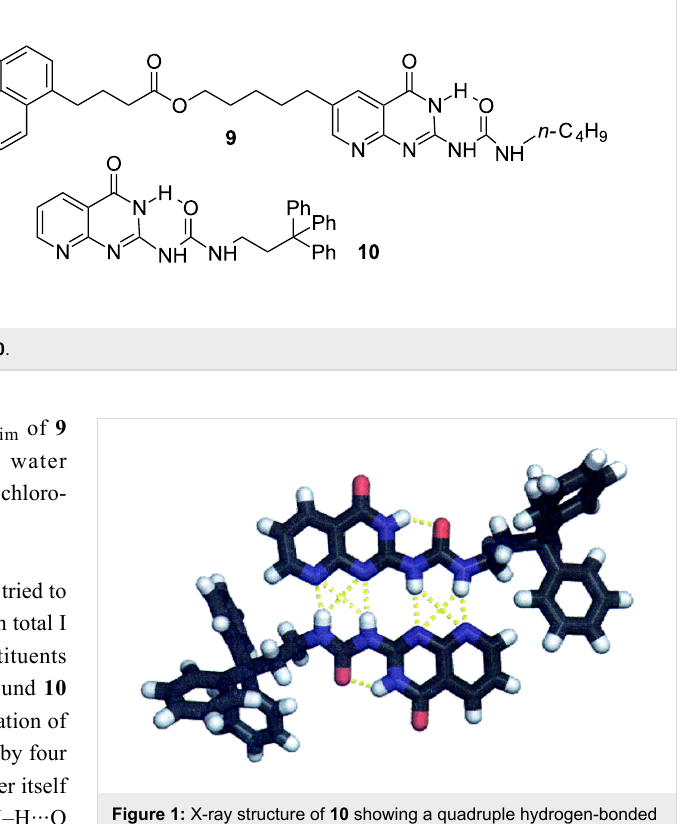
folding of linear urea derivatives driven by